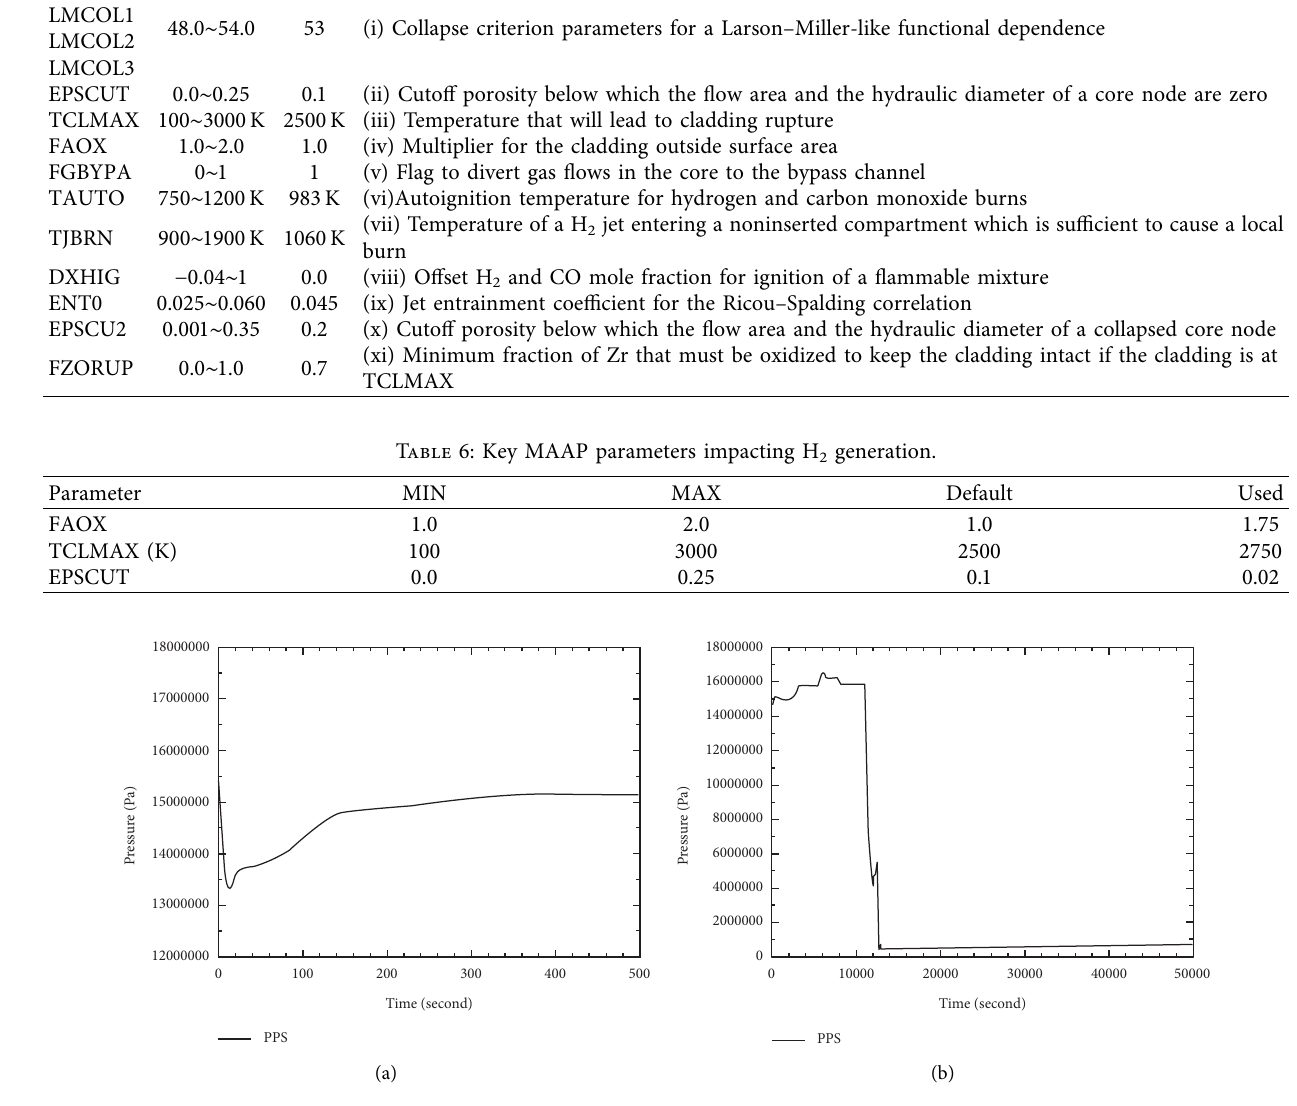
Figure 7: Pressure in primary system: (a) short term and (b) long